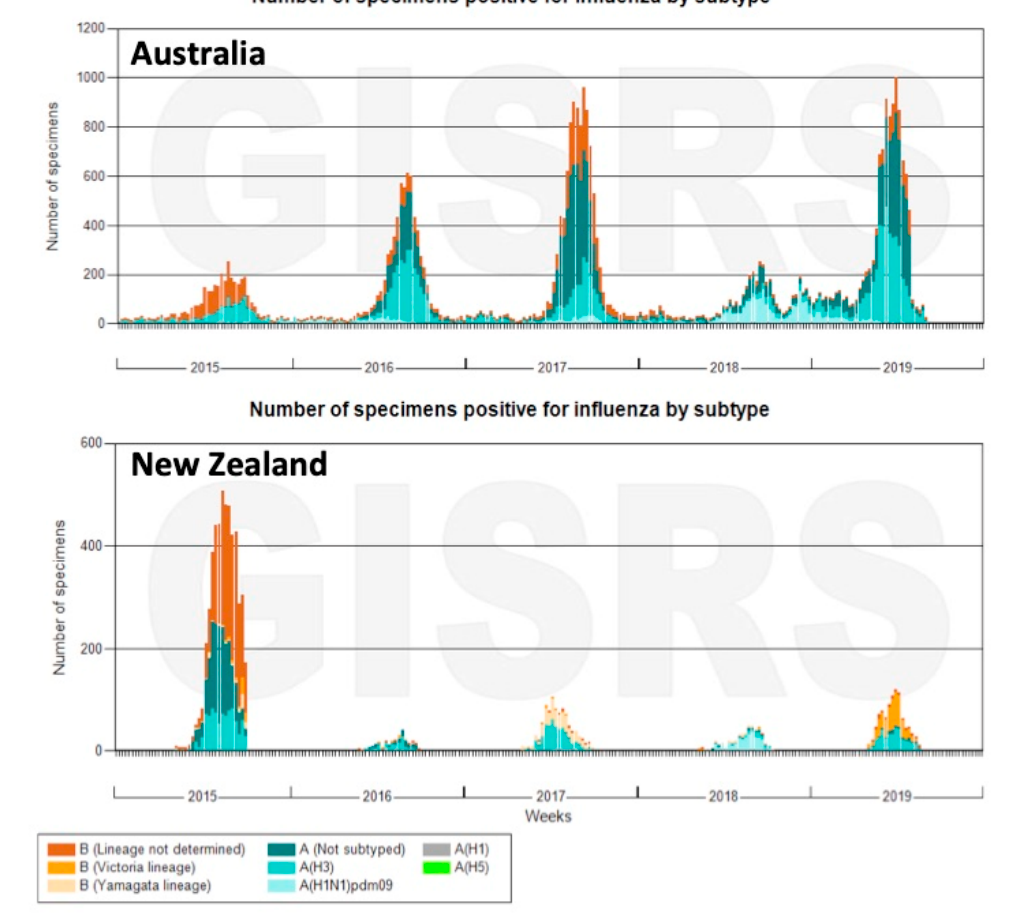
Figure 2. Laboratory-confirmed cases of influenza by type, subtype, and B-lineage reported to WHO FluNet by Australia and New Zealand National Influenza Centres from 2015–2019 (up to 4 September 2019) see